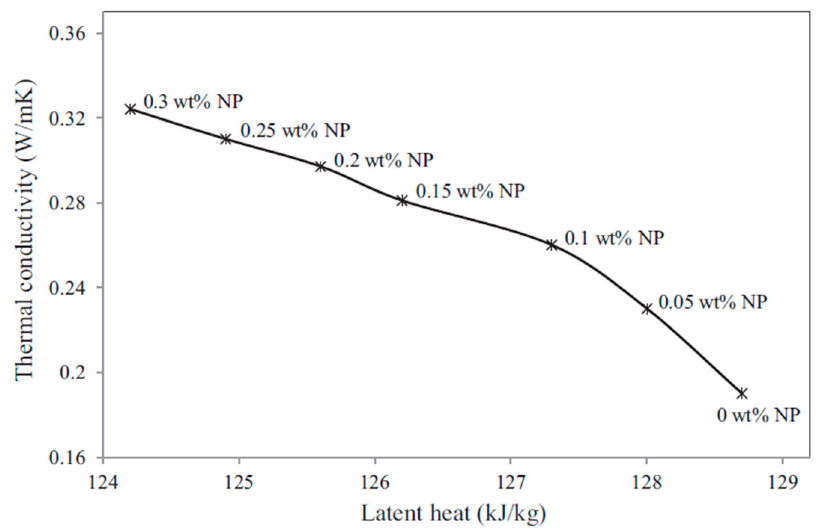
Figure 13. Thermal conductivity, latent heat, and nanoparticle wt% of stearic acid. (Reprinted with permission from ref. [27]. Copyright 2013 Thermochimica